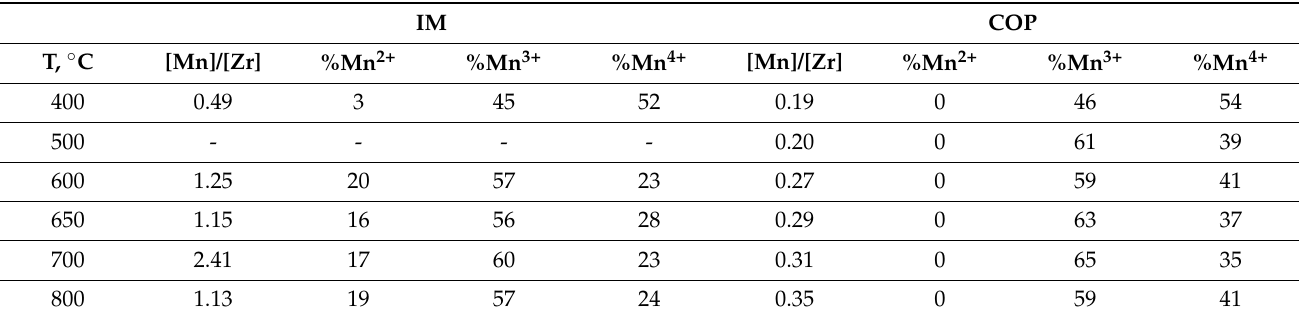
Table 2. Relative atomic concentrations of Mn and Zr cations in the near-surface layer of the studied